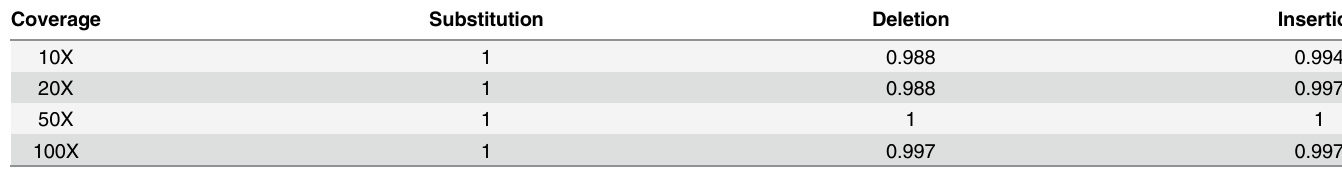
Table 2. Statistics of identified errors at different sequence